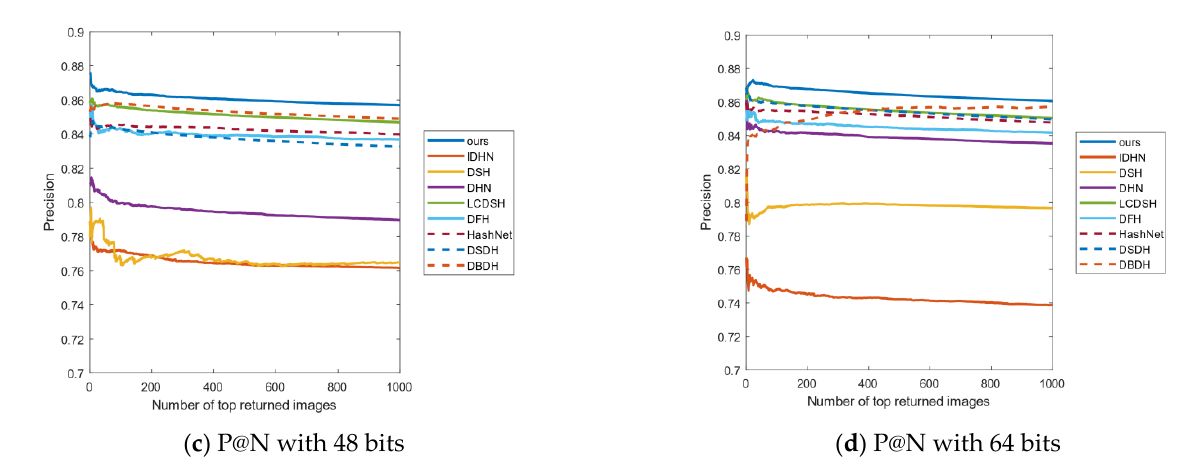
Figure 8. ( a – d ) represent the P@N curves on NUS-WIDE of all algorithms when the length of the hash code is 16, 32, 48 and 64 bits, respectively.